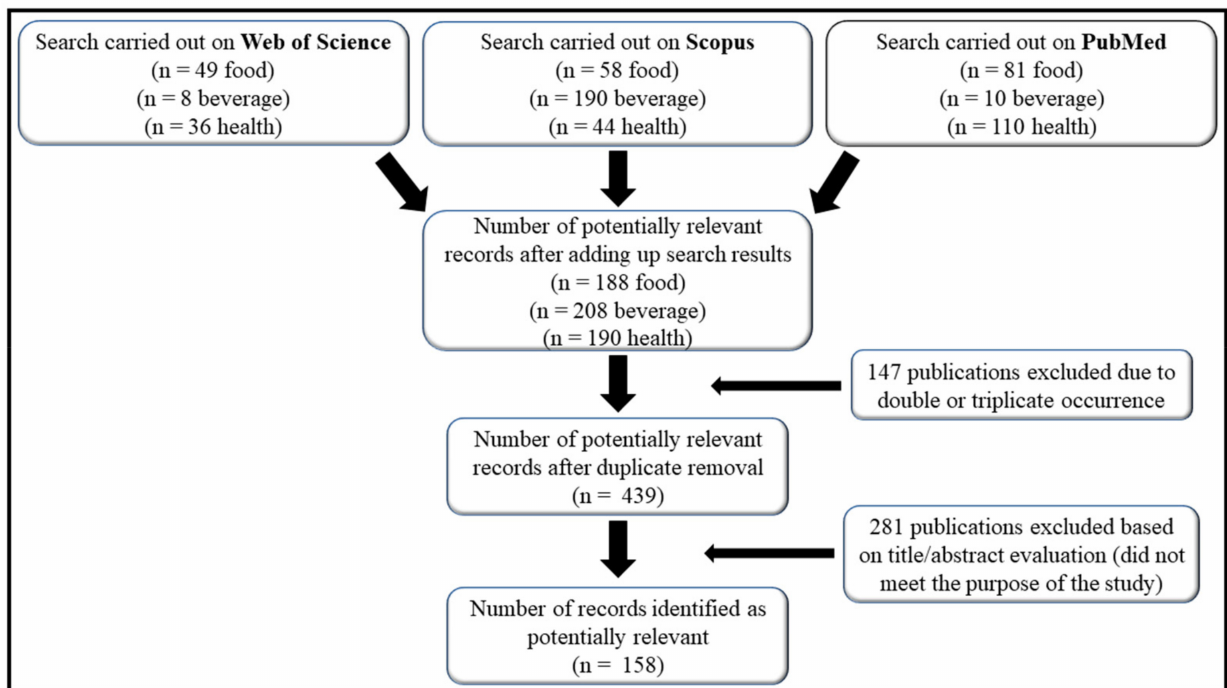
Figure 1. Flow diagram displaying the literature search results at the PubMed, Web of Science, and Scopus databases and overview of the chemometric